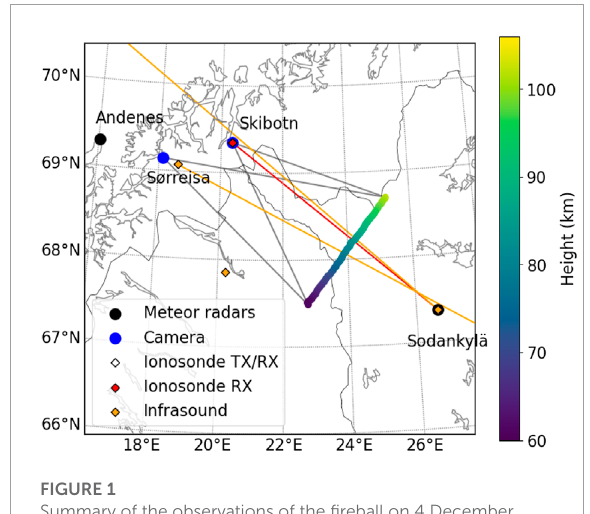
FIGURE 1 Summary of the observations of the fireball on 4